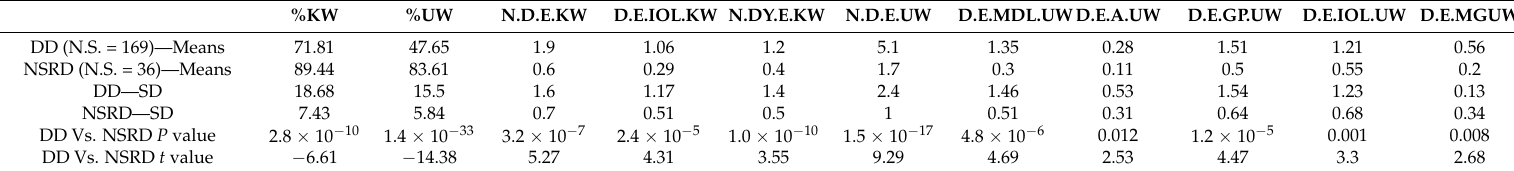
Table 3. t -test results of the spelling test of the DTRS of the two groups: mean, SD, t value and P value. N.S. = number of subjects, %KW = % known words, %UW = % unknown words, N.D.E.KW = number of dysphonetic errors of known words, D.E.IOL.UW = dysphonetic errors-insertion/omission of letters of known words, N.DY.E.KW = number of dyseidetic errors of known words, N.D.E.UW = number of dysphonetic errors of unknown words, D.E.MDL.UW = dysphonetic errors of missing double letters of unknown words, D.E.A.UW = dysphonetic errors of accent of unknown words, D.E.GP.UW = dysphonetic errors correspondence grapheme-phoneme of unknown words, D.E.IOL.UW = dysphonetic errors-insertion/omission of letters of unknown words, D.E.MG.UW = dysphonetic